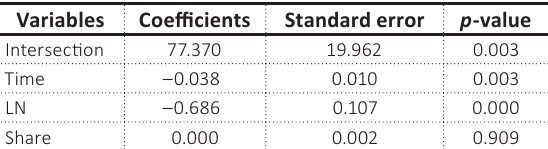
Table 3. Results of multiple linear regressions